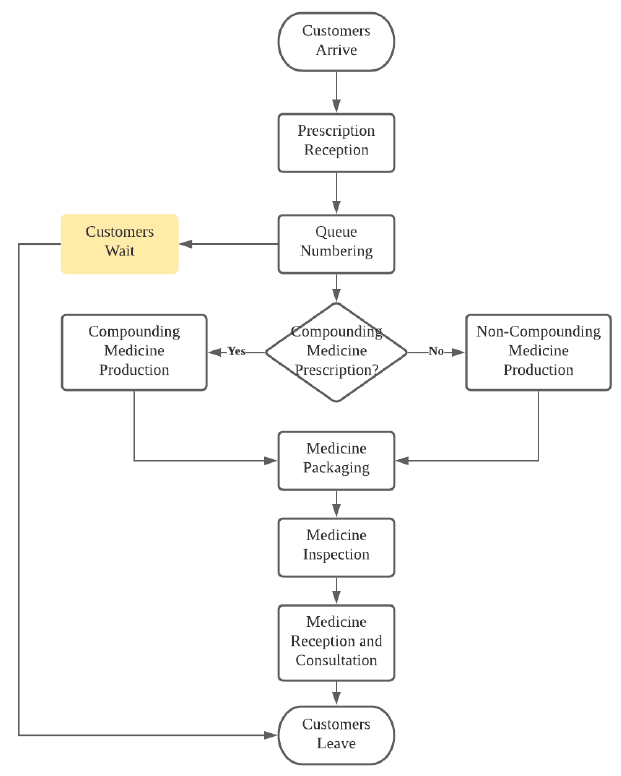
Fig. 3. Conceptual Model in the System